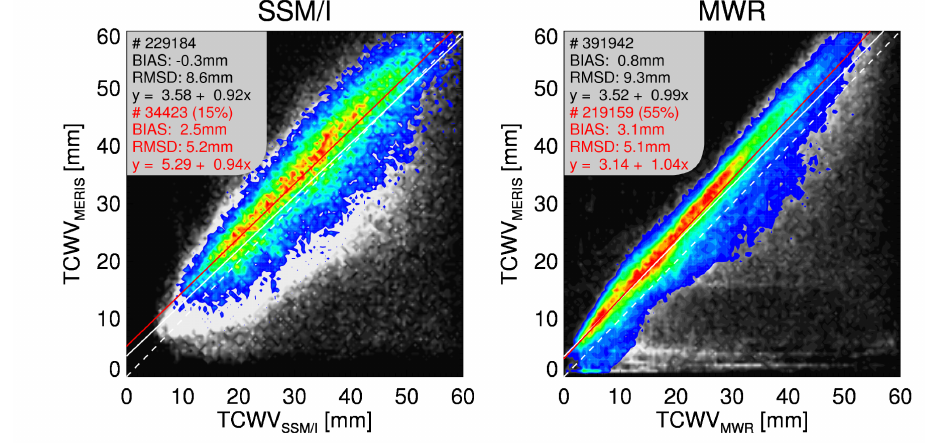
Fig. 10. Left panel: normalized frequency of occurrence for global comparison of SSM/I and MERIS TCWV over ocean (July 2007). Both retrievals were averaged within 0.5 ◦ × 0.5 ◦ degree boxes in order to account for the differing footprints and different observation times. Right panel: Normalized frequency of occurrence for direct, global comparison of ENVISAT MWR and MERIS TCWV over ocean (October– December 2002, June–September 2007). MERIS measurements were averaged within 20 × 20km 2 in order to match MWR footprint. Gray shaded background indicates distribution of compared cases without filtering, with the black text specifying statistical analysis and white solid line representing the linear fit. Color coded foreground indicates the distribution of cases, filtered for undetected clouds (lower right regions), high MERIS uncertainty and dark ocean reflectance ( ρ ≥ 0.08, applied to SSM/I comparison only). See text for more detailed